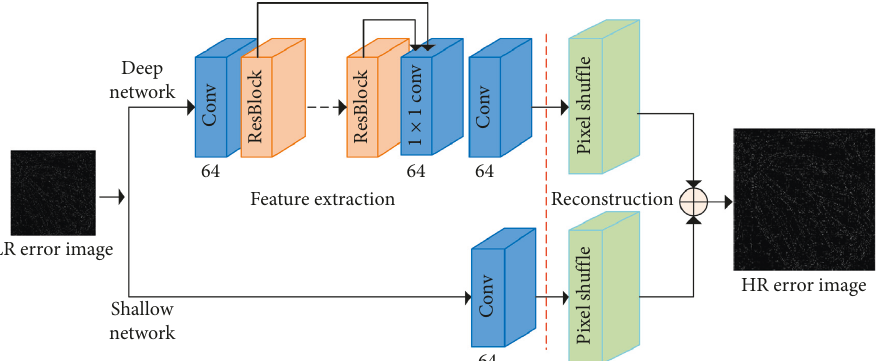
Figure 4: Network architecture diagram of error estimation. It is jointly trained by a deep network and a shallow network. Each layer network includes a feature extraction phase and a reconstruction phase.